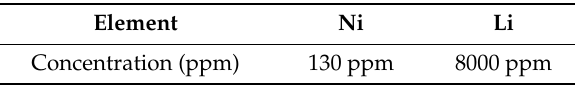
Table 1. The metal composition of leach